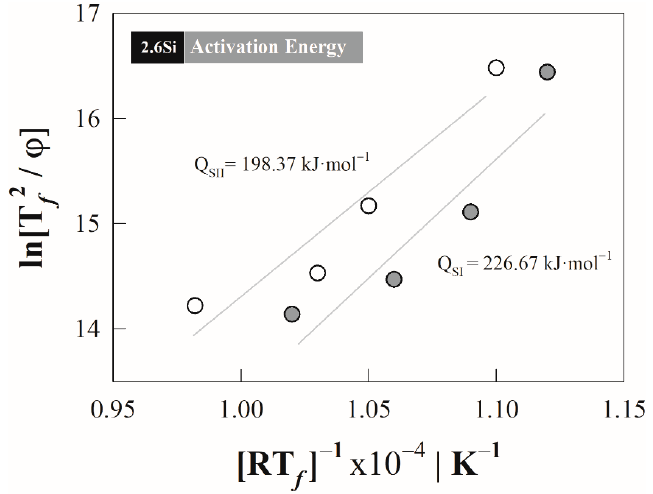
Figure 5. Activation energies in stages using the Kissinger method; the first and second stages are represented by grey and white circles, respectively.